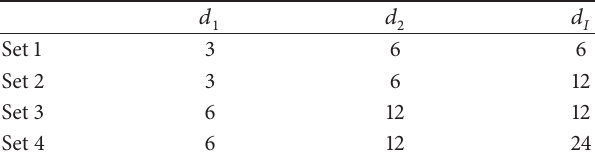
Table 1: Sets of movement threshold